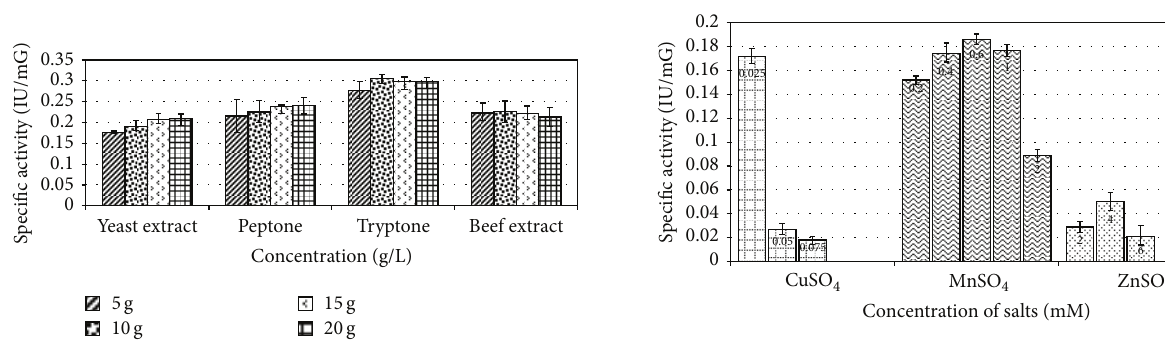
Figure 7: Effect of sugars on enzyme production. Results are expressed as the mean ± S.D ( 𝑛 = 3 ), 𝑃 -value < 0.05.